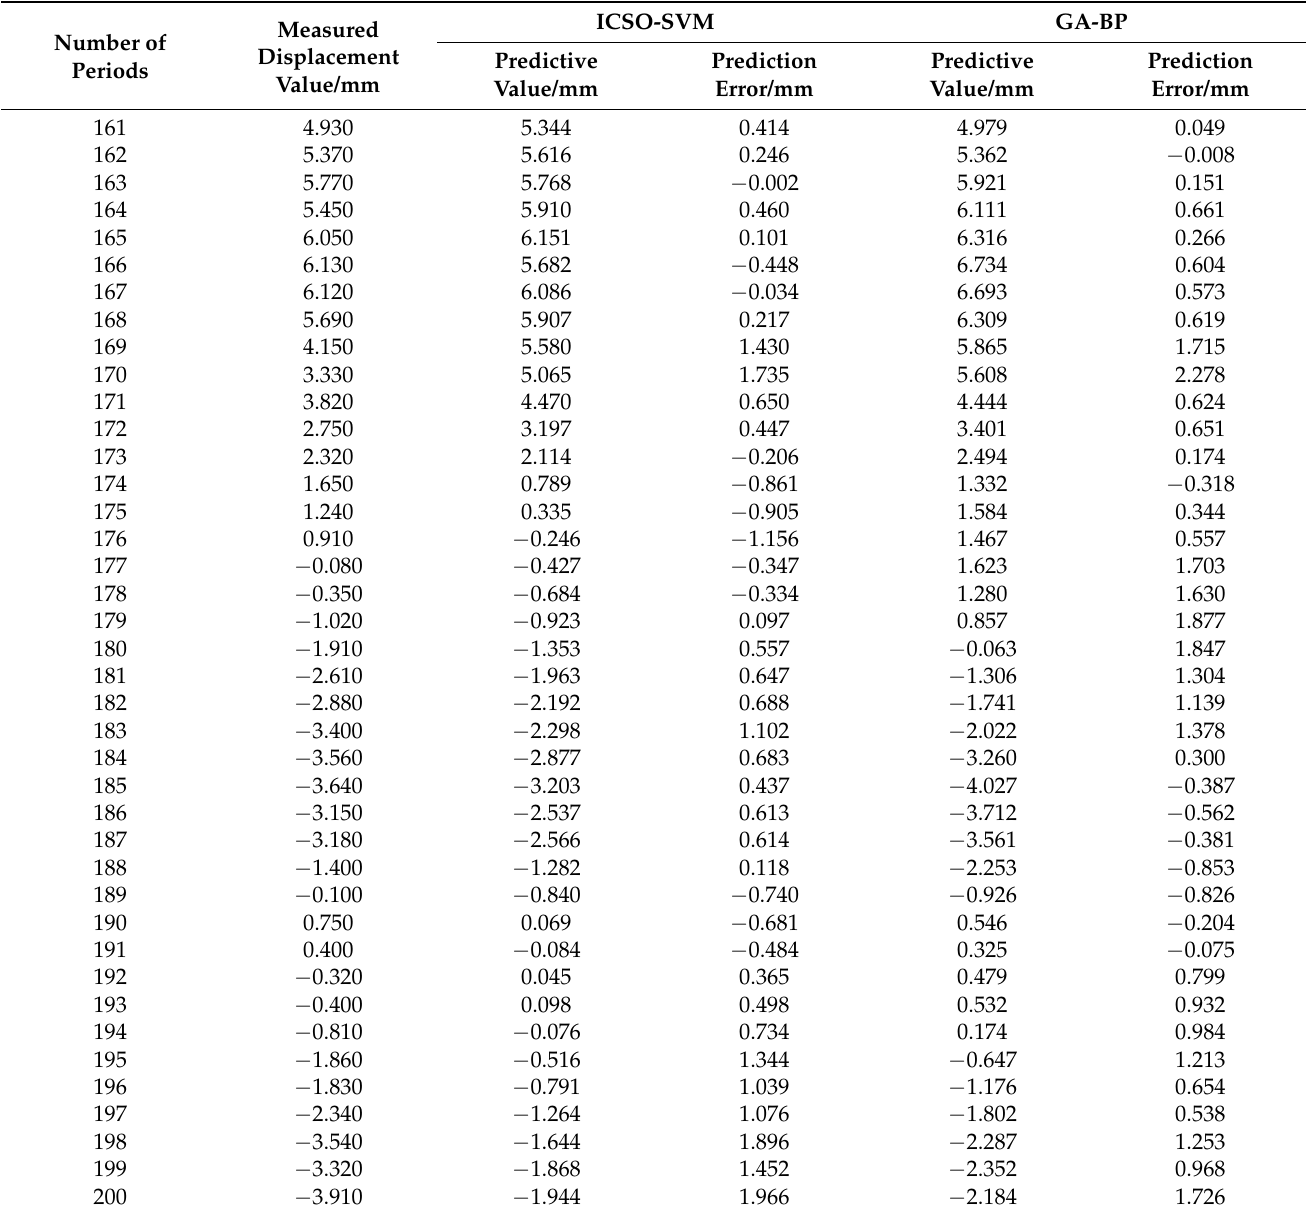
Table 4. Comparison of horizontal displacement prediction results between the ICSO-SVM and GA-BP